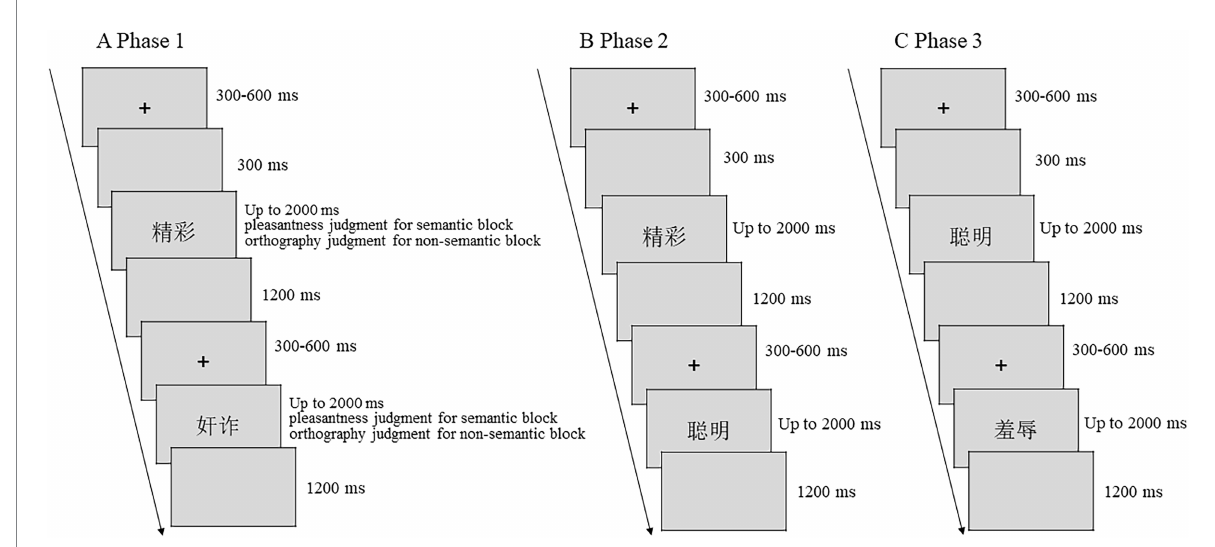
FIGURE 1 Memory-for-foils paradigm of the experiment. All variables were manipulated within